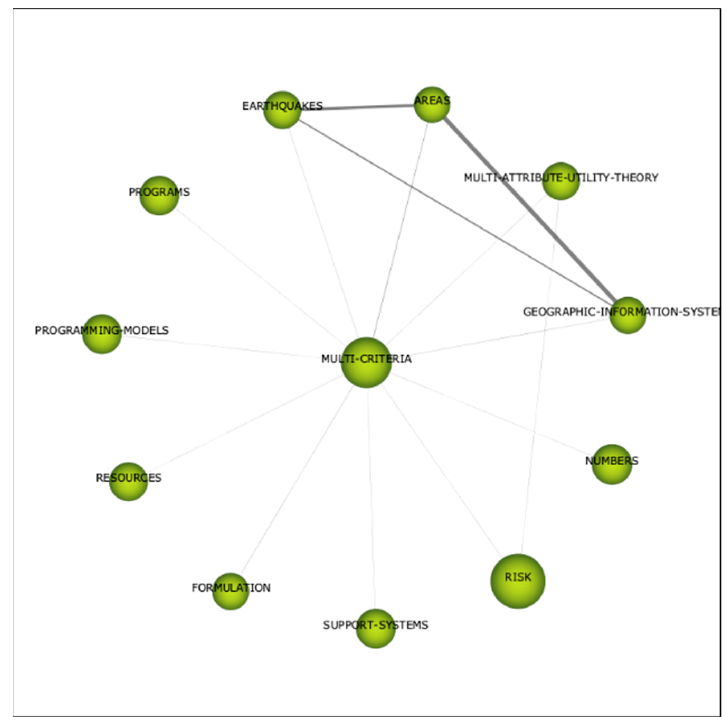
Figure A5. Multi-criteria cluster network.